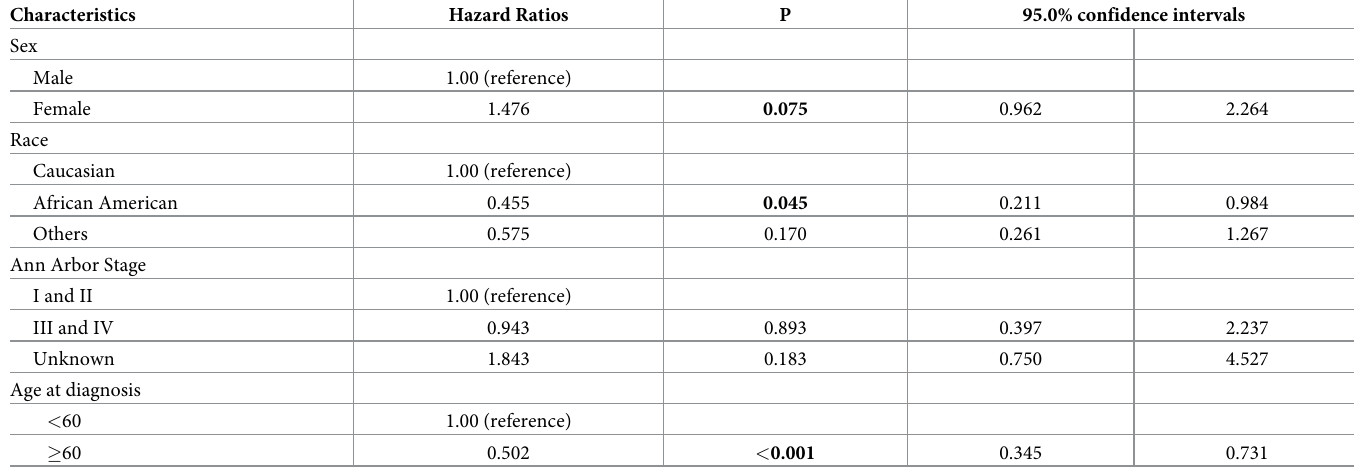
Table 3. Hazard ratios and 95% confidence intervals of Cox regression for Mortality Among Patients With extra nodal natural killer/T-cell lymphoma, nasal type Diagnosed Among US Veterans From 1987 to 2014.